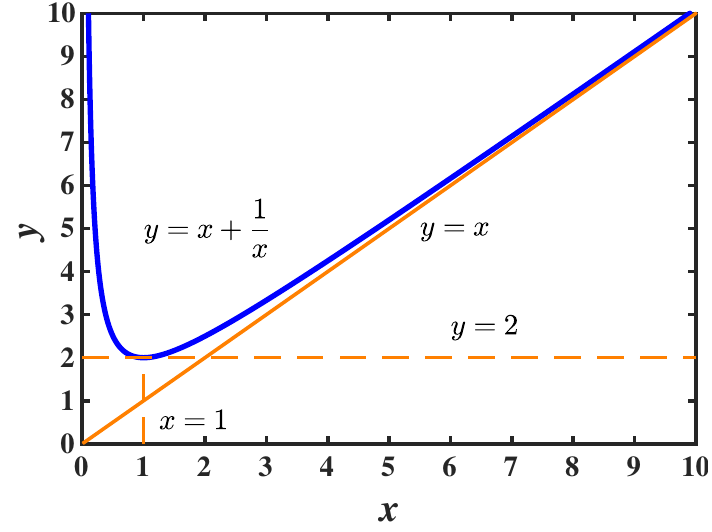
Figure 11. The curve of the typical hook